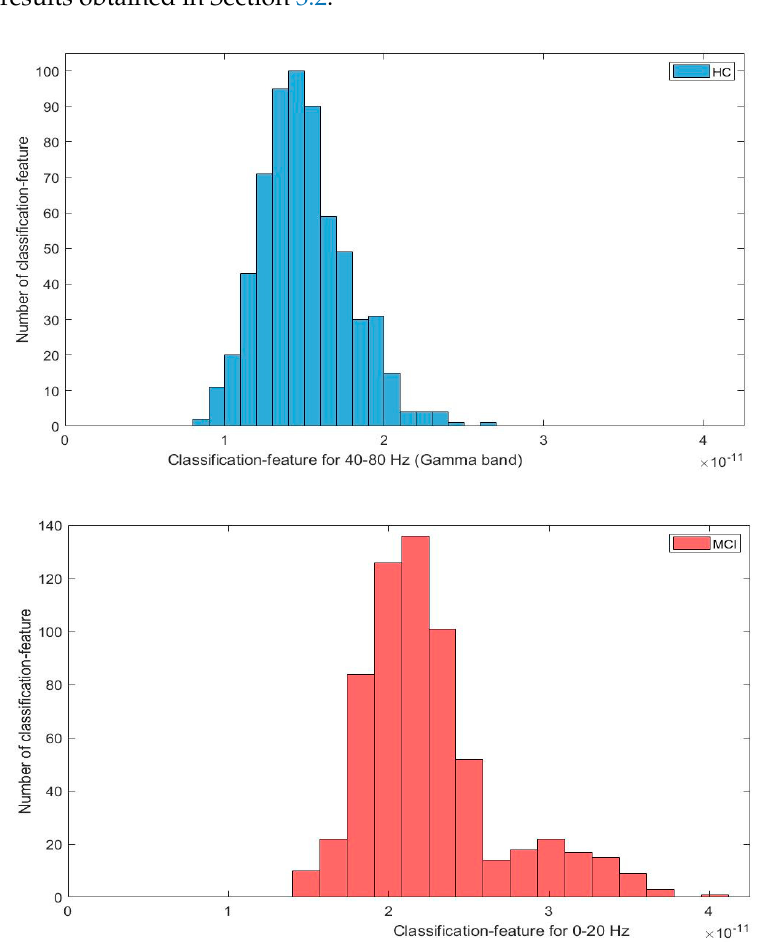
Figure 6. Distributions of the classification features of two frequency ranges. The HC and MCI distributions are set as the same range for comparison.